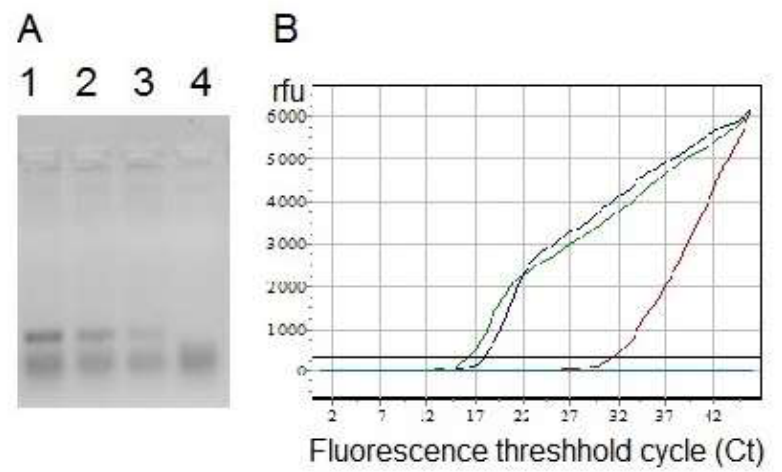
Figure 5. Analysis of the nuclease activities of ENP. ( A ) Electropherogram of PCR product of 153 bp long before (lane 1) and after treatment with DNase NP 0.001 mg/mL (lane 2), 0.01 mg/mL (lane 3) and 1 mg/mL (lane 4) in 2% agarose gel 1xTBE buffer with ethidium bromide staining. ( B ) Data of reverse transcription with real-time PCR for β-coronavirus SARS-CoV-2 RNA from COVID-19 pa- tient blood leukocytes in the presence of the ENP consisting of DNase I, RNase A or trypsin. Calcu- lation of the fluorescence threshold cycles (Ct) for each well is shown in Supplementary Materials Table S1.